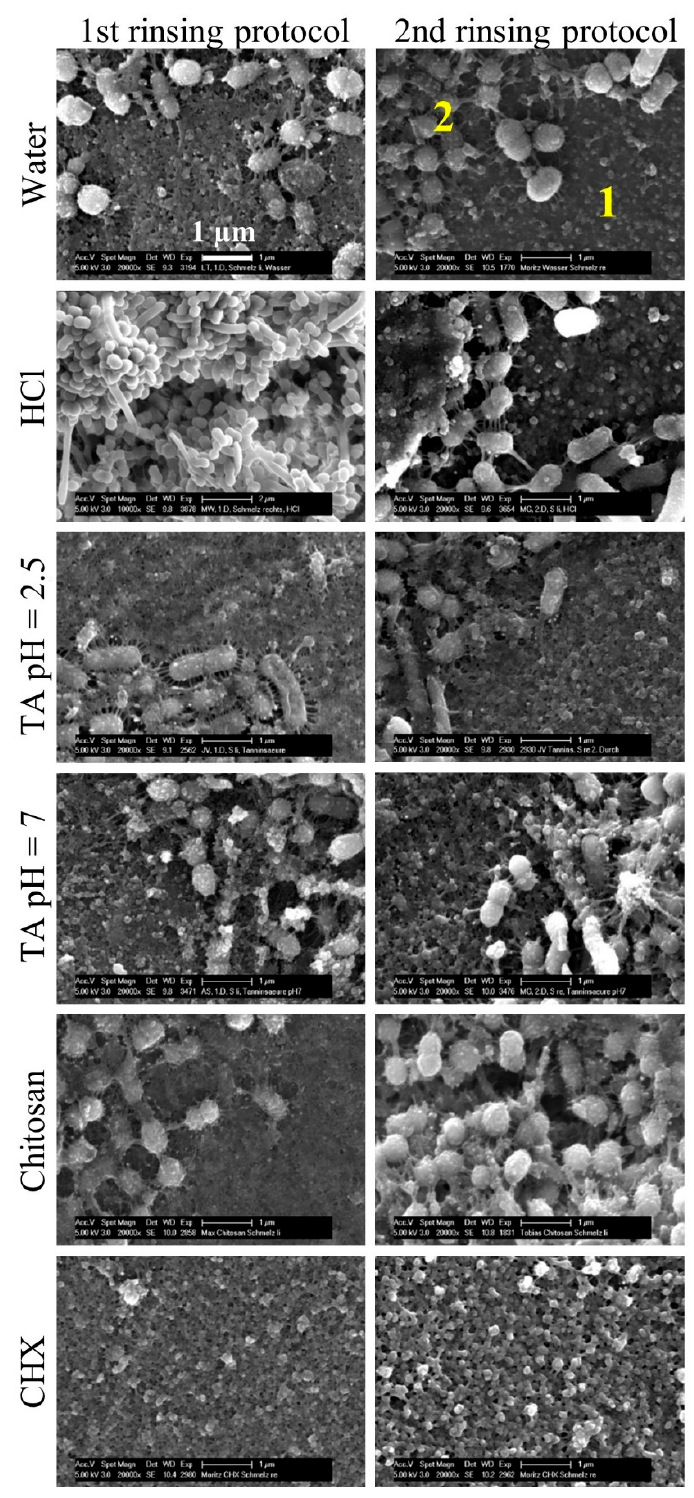
Figure 7. Representative scanning electron micrographs of specimens in 20,000-fold magnification. Bovine enamel specimens were attached to upper jaw splints that were carried by subjects ( n = 6) for 48 h. In the first protocol, rinsing occurred 5 times and, in the second protocol, 4 times with di ff erent experimental solutions. Micrographs show specimens covered by a biofilm that consists of the pellicle (1) and bacteria (2). HCl = hydrochloric acid, TA 2.5 = tannic acid (pH = 2.5), TA 7 = tannic acid (pH = 7) and CHX =